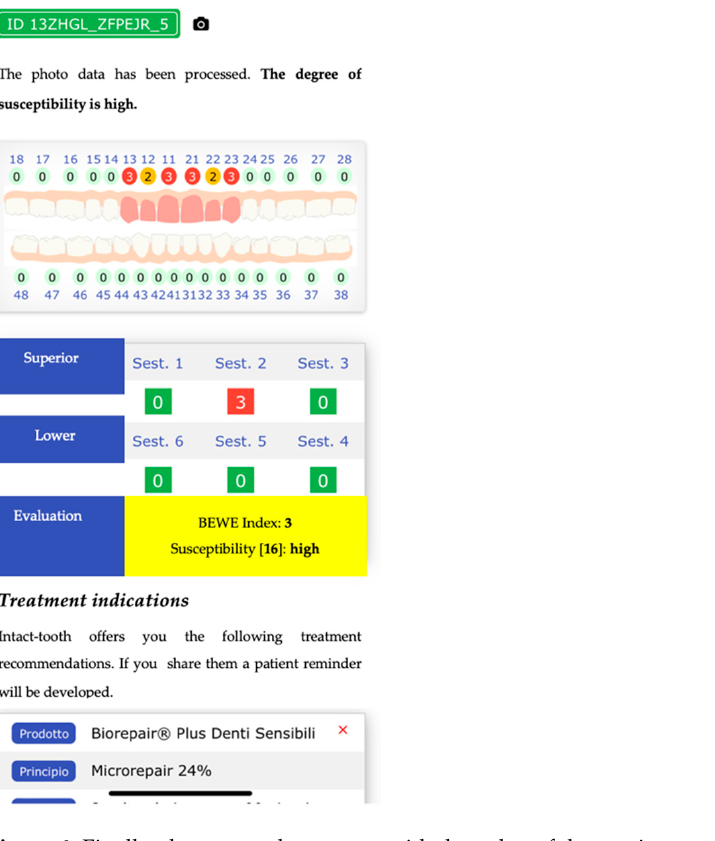
Figure 6. Finally, shows an odontogram with the value of the erosion status awarded by the